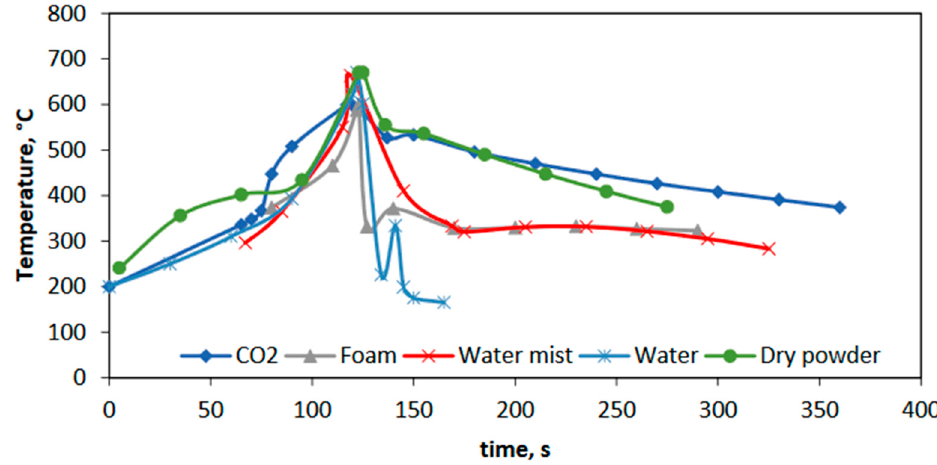
Figure 13. Extinguishing battery fire with different extinguishing agents [149].